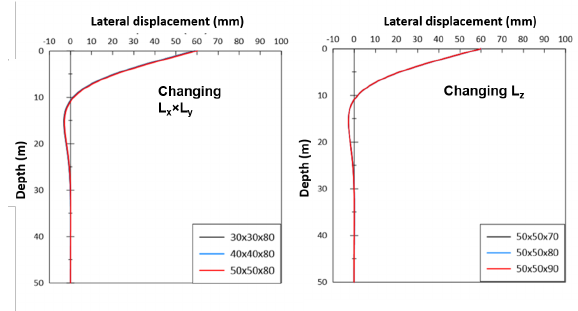
Fig. 3. Verification on solutions of the FE analysis with the size of analytical zone